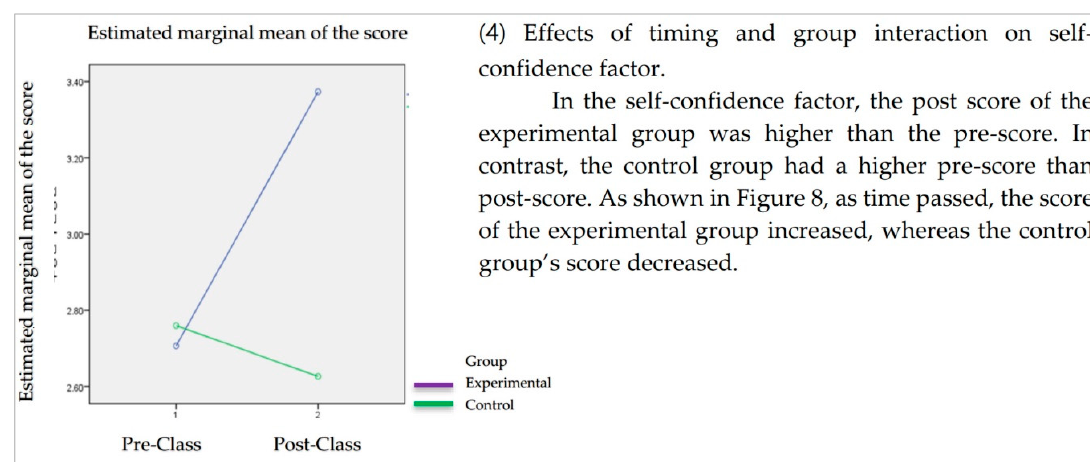
Figure 8. Effect of timing and group interaction on Confidence.